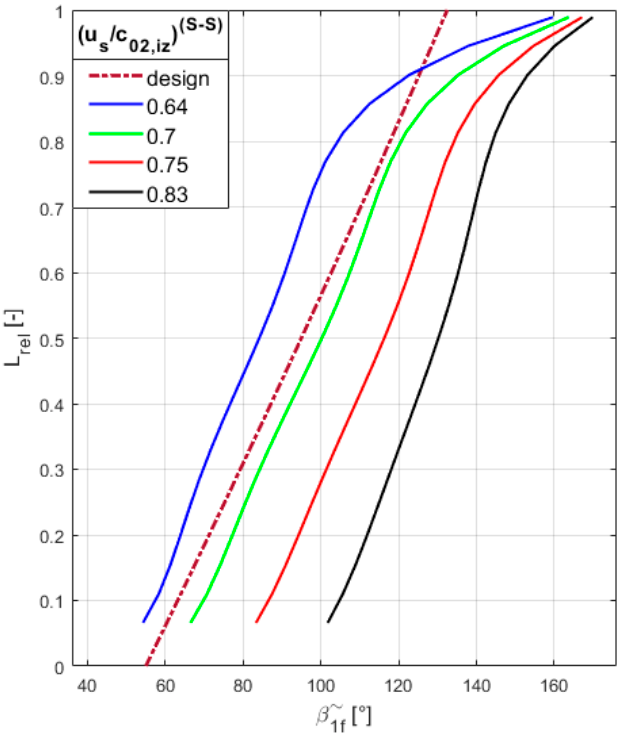
Figure 12. Pitchwise-mass-averaged bucket inlet relative velocity radial distributions. The stated dependences represented mass-averaged data, i.e., one representative mean value of the monitored parameter was always determined for the selected blade